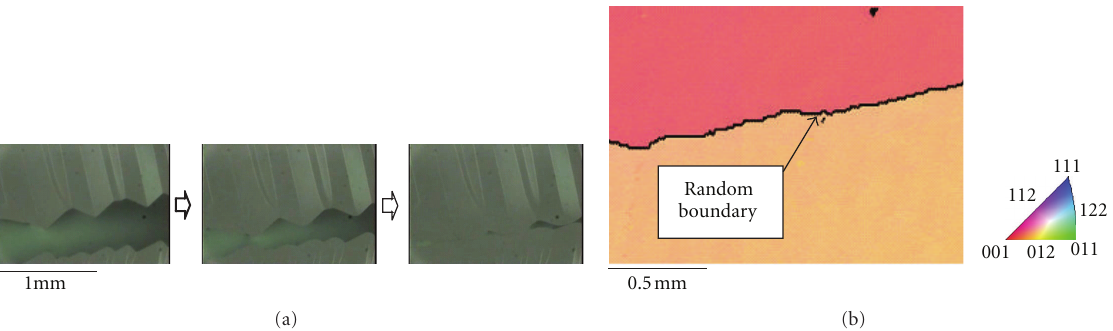
Figure 9: (a) Growth behavior of two Si crystals with zigzag-faceted interfaces [41]. It is observed that the sharp corners on the faceted interfaces gradually disappear as the crystals grow. (b) Result of EBSP analysis of the sample shown in (a) [41]. The growth direction vertical to the line indicated in (b) is shown in color.